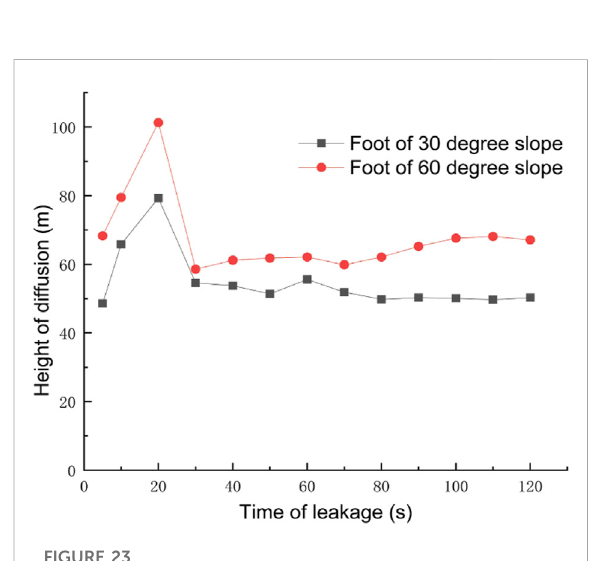
FIGURE 24 Diffusion height map of pipelines laid at the surface of the slope at different